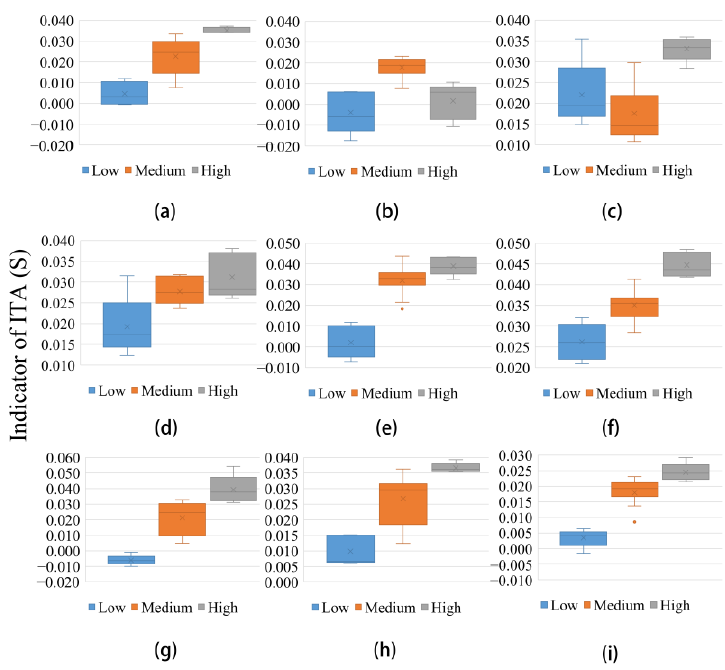
Figure 8. Median value of S (indicator of ITA) for maximum temperature over the whole Jinsha River Basin (JRB): ( a ) annual, ( b ) spring, ( c ) summer, ( d ) autumn, ( e ) winter. Annual maximum temperature in the sub-basins ( f ) SRJRB, ( g ) UPJRB, ( h ) YLRB, and ( i ) MLJRB. Blue, orange, and gray box denote the low, medium, and high categories, respectively.